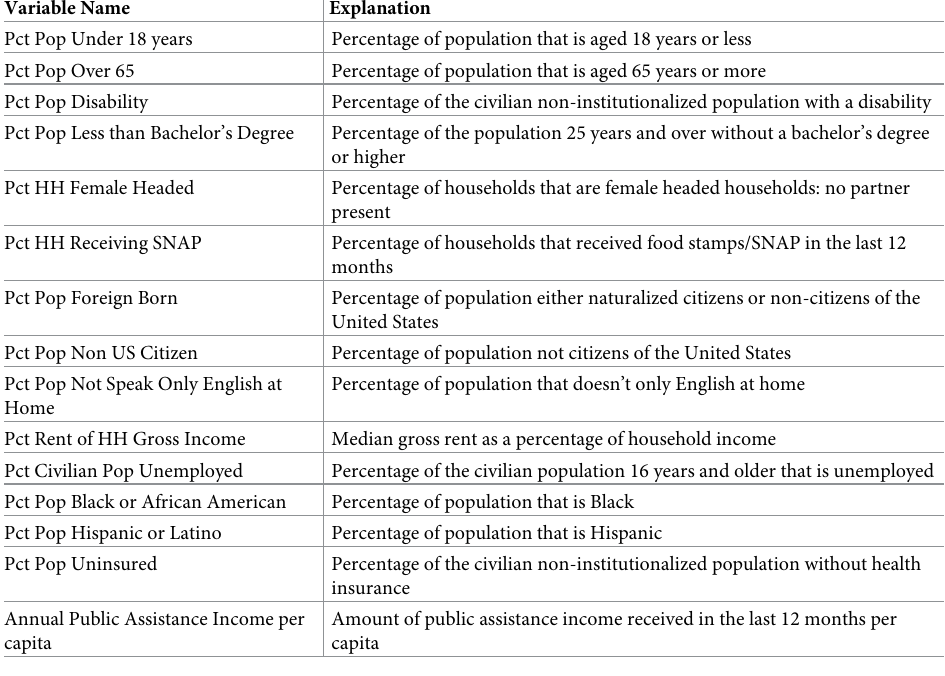
Table 3. Definition of demographic and socio-economic variables used in bivariate